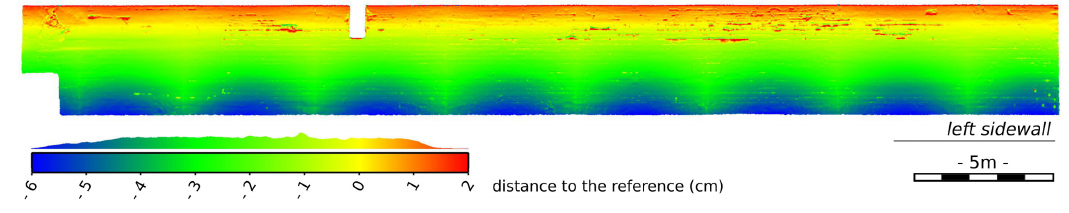
Figure 10. Front view of distances between MSS cloud and TLS mesh for (top) the left sidewall and (bottom) the right sidewall